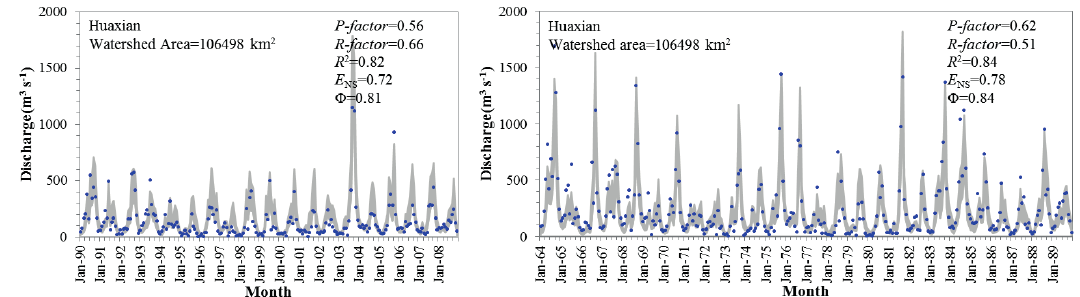
Fig. 2 Comparison between the measured (dots) and simulated (95PPU band, shaded area) monthly hydrographs at Huaxian station for both calibration (left) and validation (right) period.